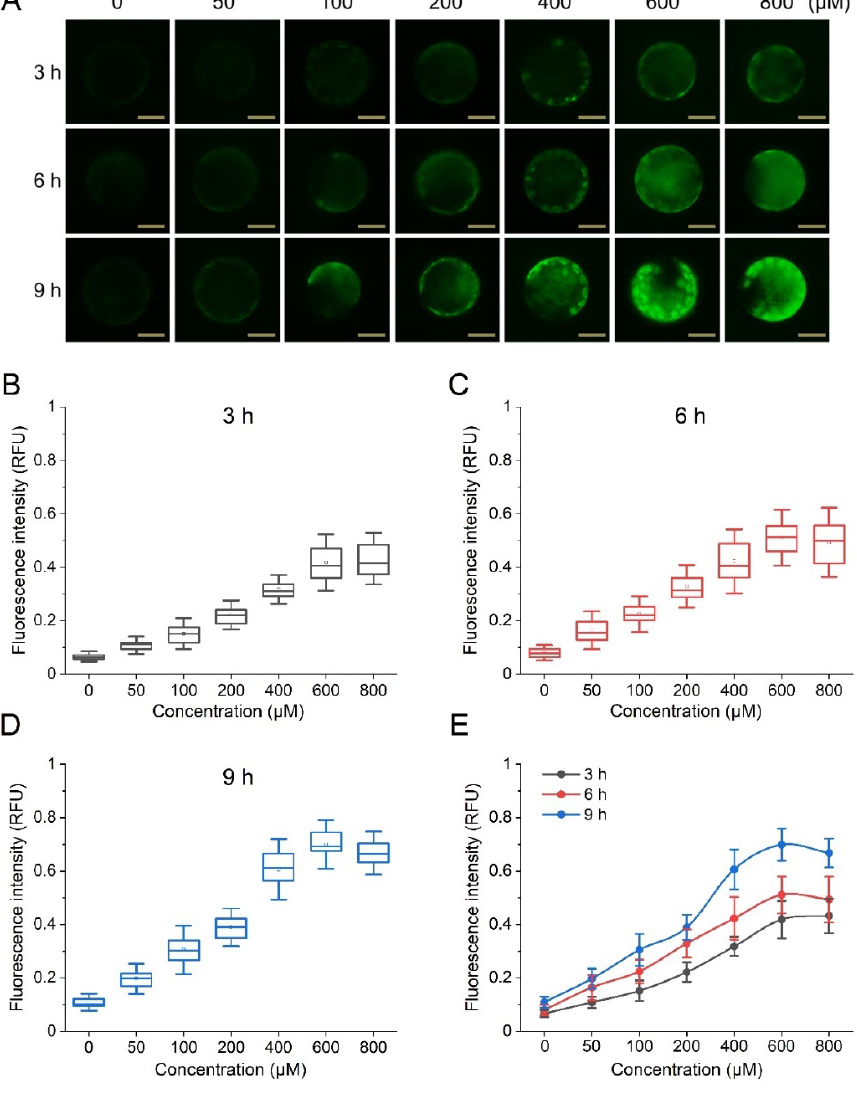
Figure 2. Exogenous H 2 O 2 -mediated changes in ROS content of Arabidopsis protoplasts. ( A ) Fluorescence images of protoplasts with a scale of 25 µ m; ( B – D ) fluorescence intensity gradients induced by H 2 O 2 concentration in protoplasts after 3, 6, and 9 h, respectively; ( E ) effect of H 2 O 2 treatment time on the fluorescence intensity of protoplasts.